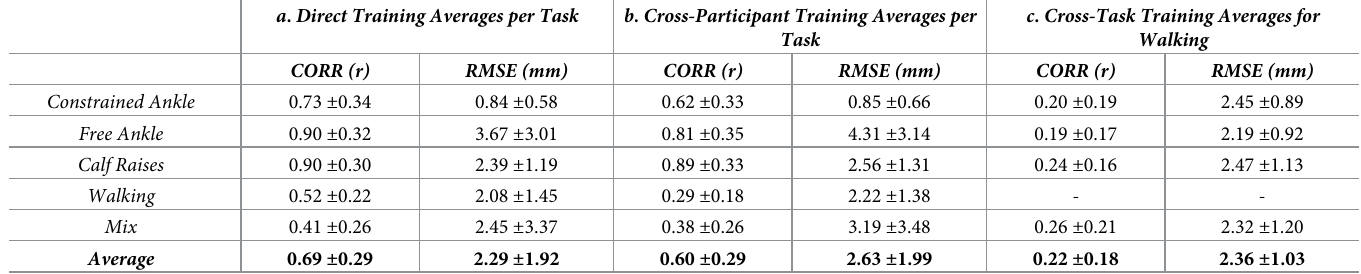
Table 2. Ankle movement task comparisons for SVM across training